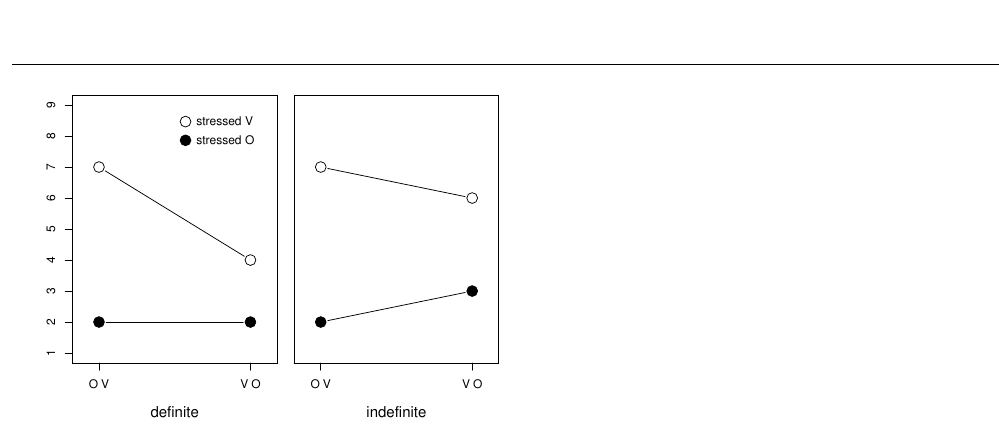
Overall results from experiment 1 , repeated for comparison